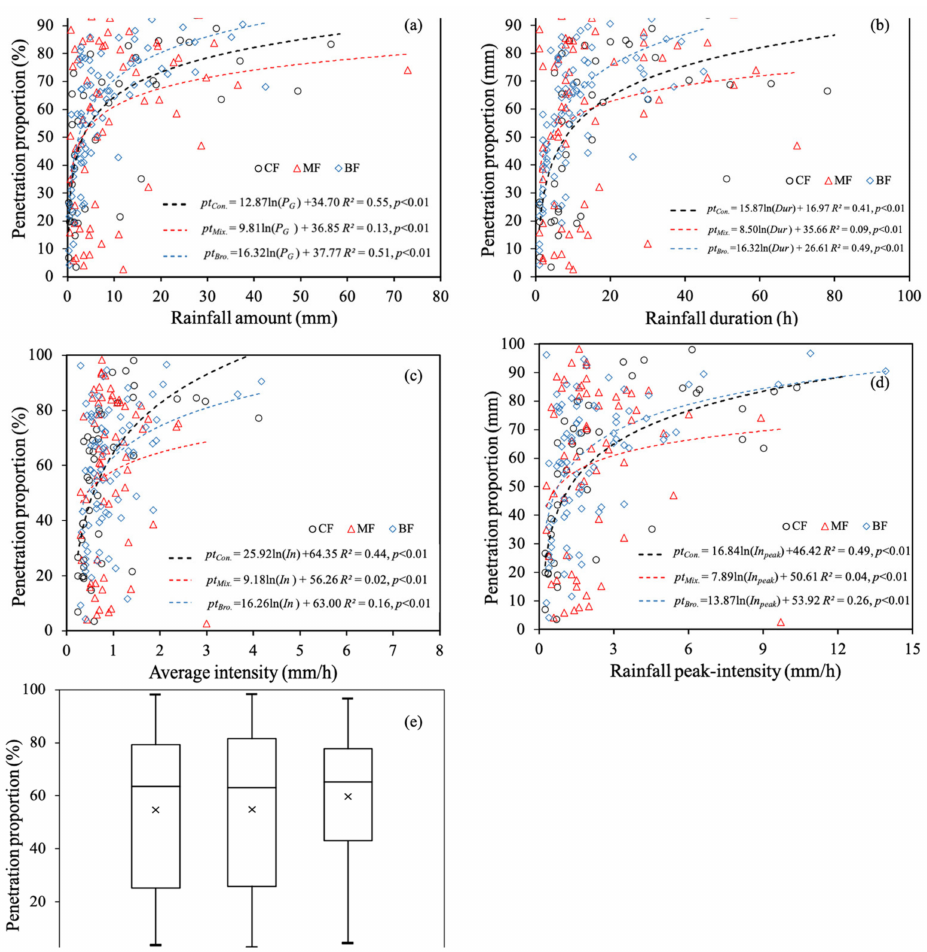
Figure 5. Throughfall penetration proportion as a function of individual rainfall amount ( a ), duration ( b ), average intensity ( c ), and peak intensity ( d ). Box plots in ( e ) depict the mean, median, 25th, and 75th percentile values of throughfall amount in CF, MF, and BF. The whiskers show the maximum and minimum values of throughfall